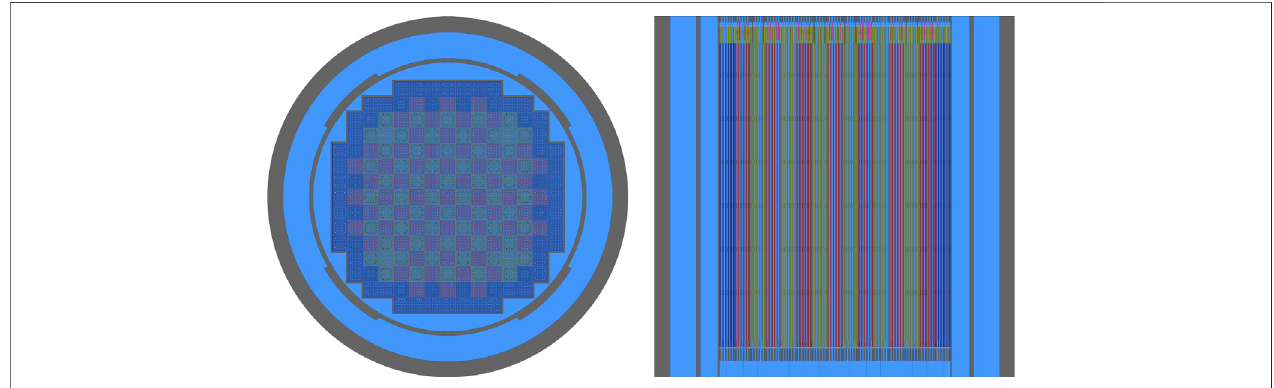
FIGURE 3 | The BEAVRS benchmark